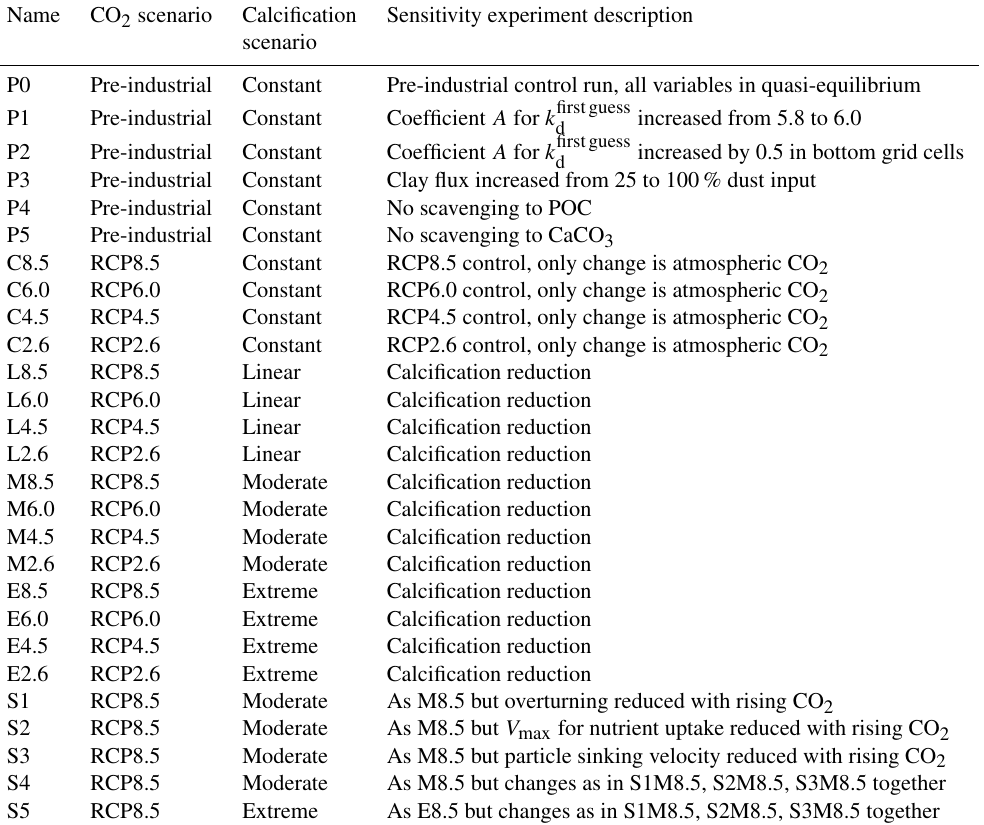
Table 2. Model runs’